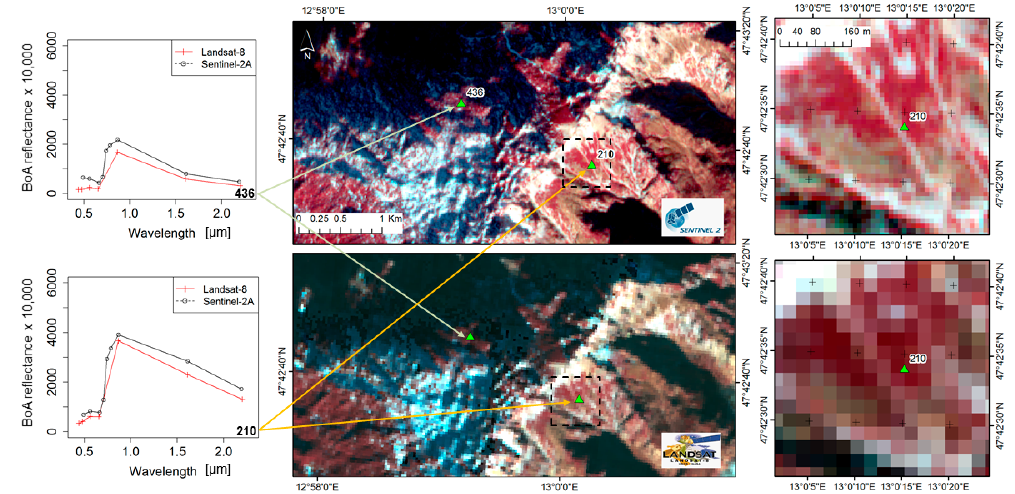
Figure 7. Spectral mismatch between Landsat-8 and Sentinel-2 observed over heterogeneous and complex surface terrain. The maps on the right show a zoom in on point “210”. BoA reflectance values are scaled by 10,000.